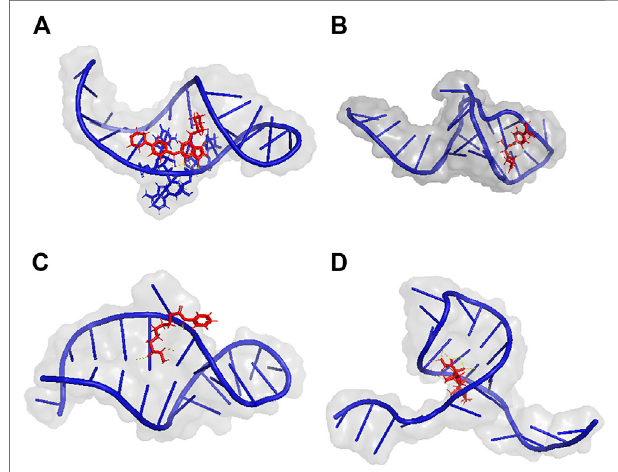
FIGURE 6 | Molecular docking of CID210332 (hsa-miR-3131), CID444732 (hsa-miR-3614 – 3p), CID5311 (hsa-miR-3131), and CID5743 (hsa-miR-3616 – 3p). (A) An interaction between CID210332 and hsa-miR- 3131 occurs at nucleotides 6 – 9. (B) An interaction between CID444732 and hsa-miR-3614 – 3p) occurs at nucleotides 5 and 12. (C) An interaction between CID5311 and hsa-miR-3131 occurs at nucleotides 5, 6, and 8. (D) An interaction between CID5743 and hsa-miR-3616 – 3p) occurs at nucleotides 8, 15, 16, and 17. The mall molecules, RNAs, and Hydrogen bonds are colored in red, blue, and yellow. Details about the lowest binding energy values are listed in Table 5 .